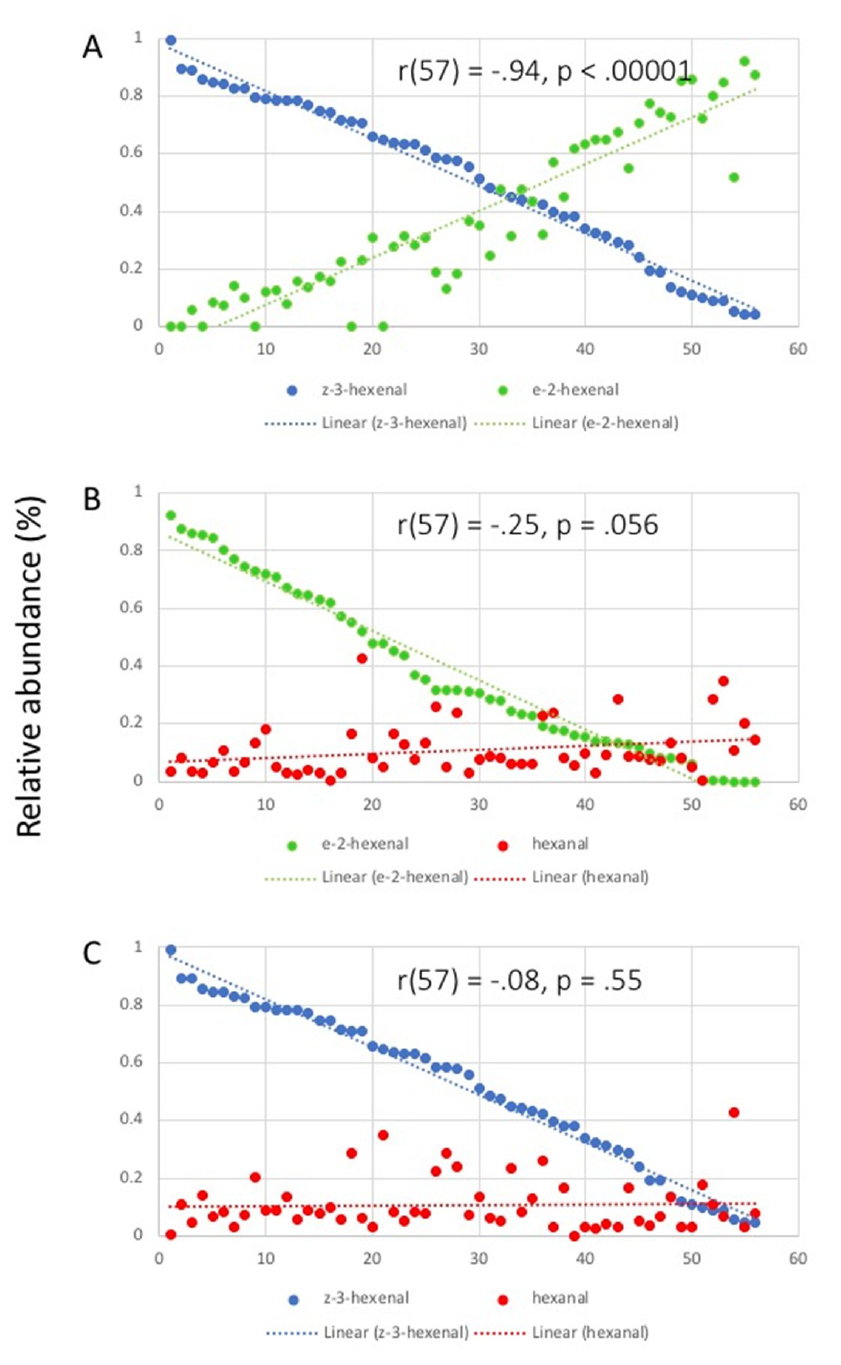
Figure 5. Correlation between relative proportions of individual compounds after damage. ( A ) correlation of ( Z )-3-hexenal with ( E )-2-hexenal; ( B ) correlation of ( E )-2-hexenal with hexanal; ( C ) correlation between ( Z )-3-hexenal and hexanal. Correlation coefficients ( r ) and p -values are shown on the graphs. Trendlines are shown in corresponding colors (dotted lines). Results for each plant are averages from at least three biological replicates.